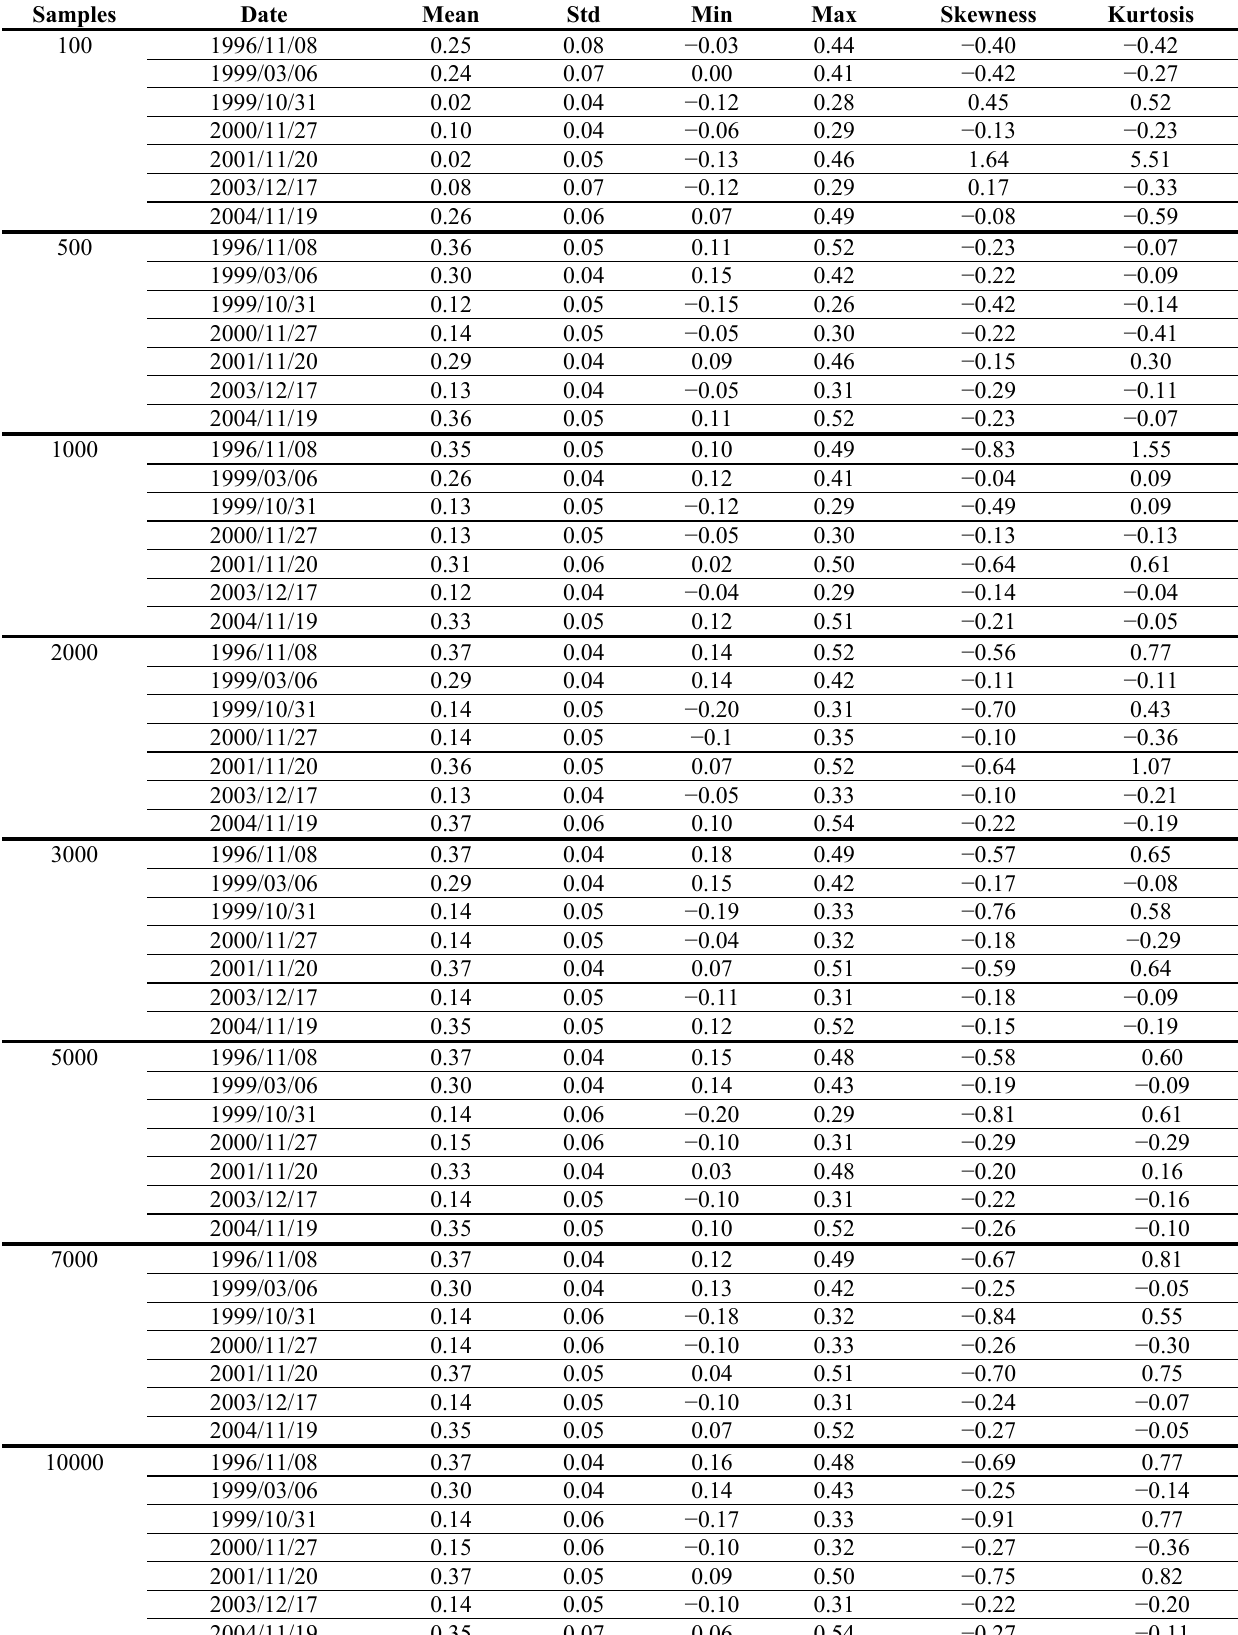
Table 4. Statistics of SGS simulations with different samples from NDVI images.